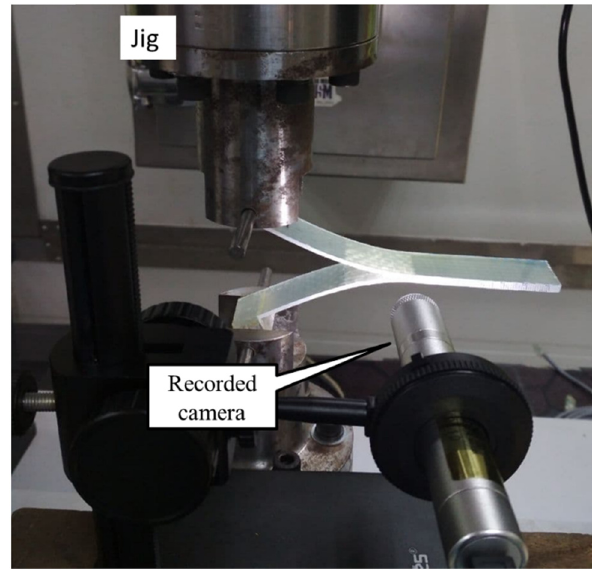
Figure 5: Experimental setup for DCB test.